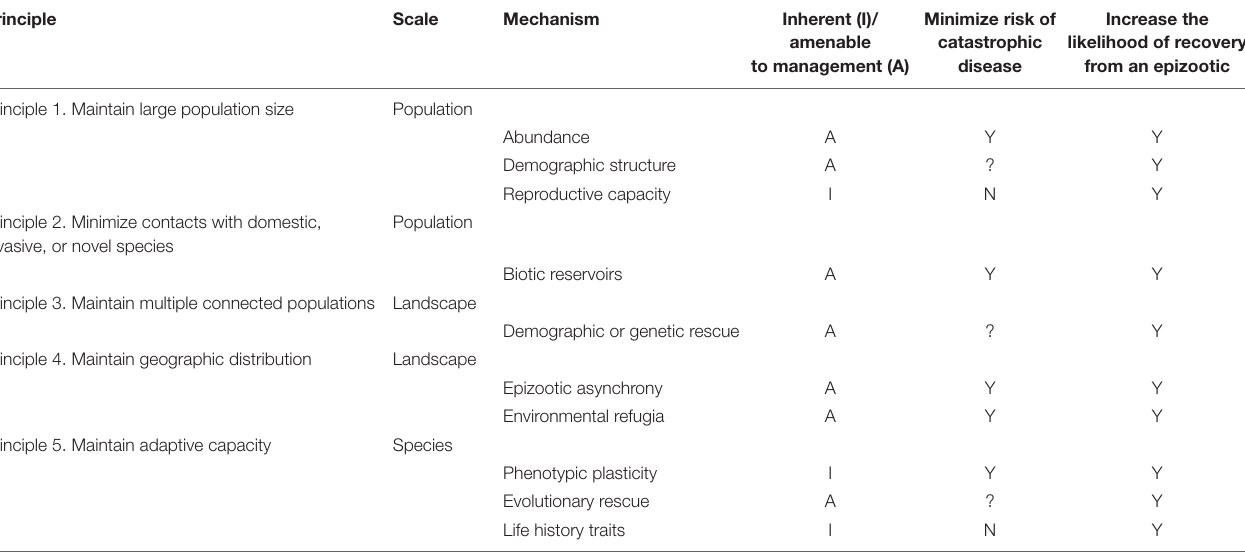
TABLE 1 | Summary of principles and mechanisms that minimize species extinction risk following an epizootic, increase the likelihood of recovery from an epizootic, and mitigate the effects of future epizootics.